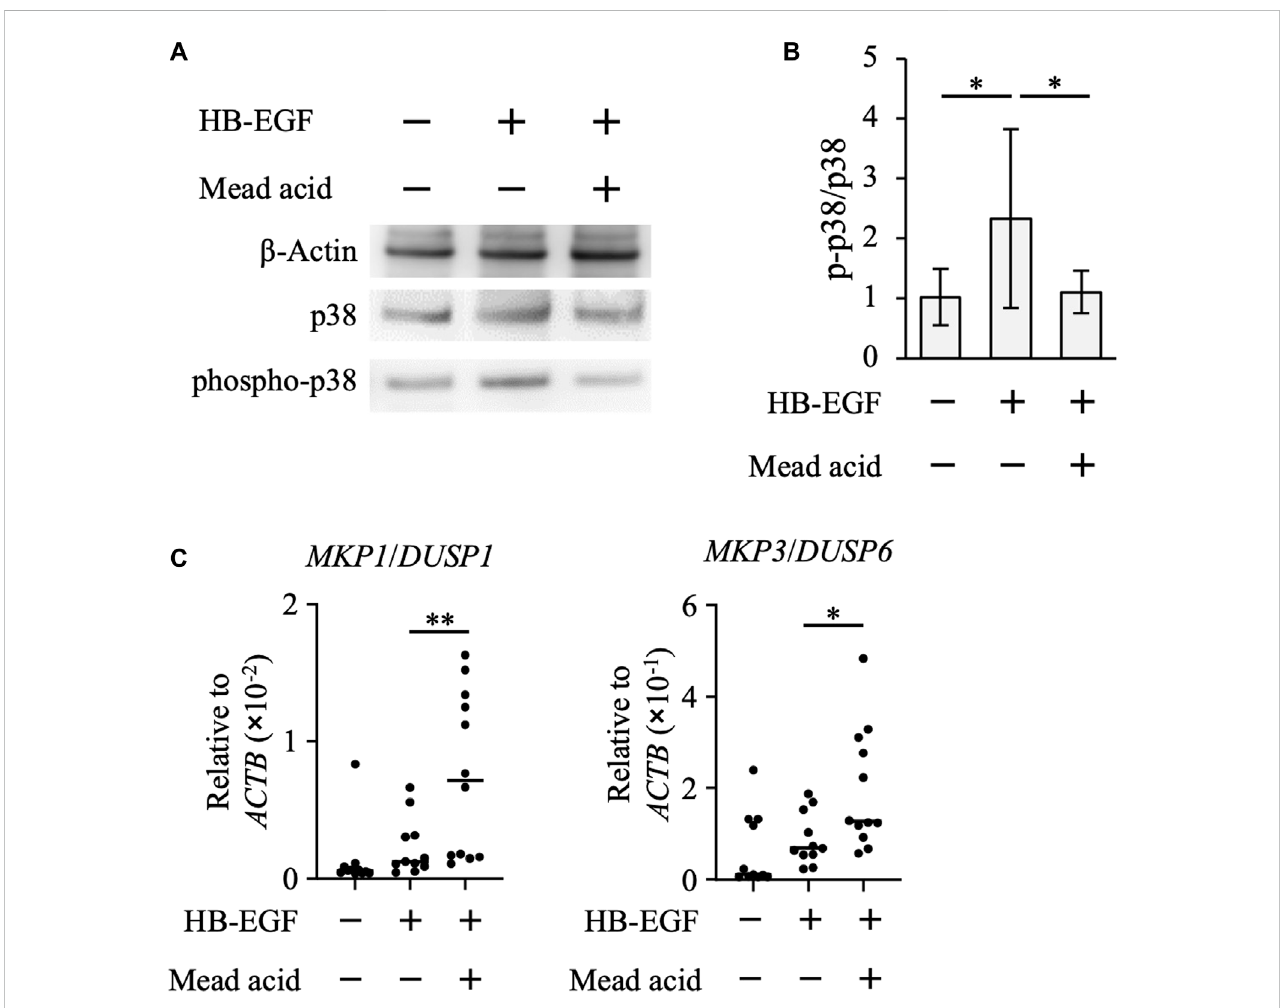
Mead acid attenuates p38 MAPK activation. HaCaT cells were pretreated with mead acid or vehicle before stimulation with HB-EGF (1 ng/mL). (A) The expression levels of phospho-p38, p38, and β -actin were measured by western blotting. Representative images from three independent experiments are shown. (B) The ratio of phospho-p38 to p38 was calculated by dividing the intensity of expression of phospho-p38 by the intensity of that of p38. (C) The expressionlevelsof MKP1 / DUSP1 and MKP3/DUSP6 weremeasuredbyquantitativeRT-PCRanalysisandnormalizedtothatof ACTB .Dataarecombined from four independent experiments. * p < 0.05; ** p <